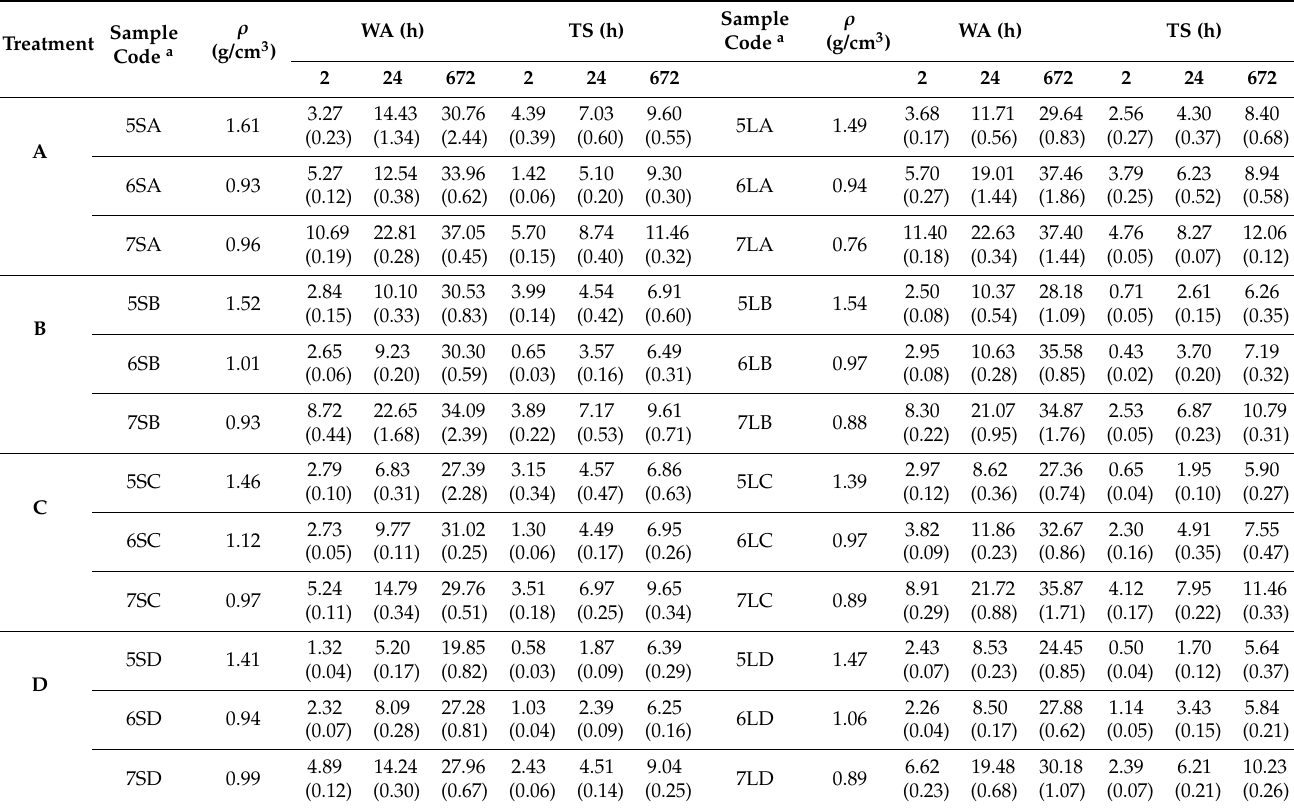
a refer to Table 1 for the WPC treatment composition and corresponding codes. (Values in parenthesis are the standard